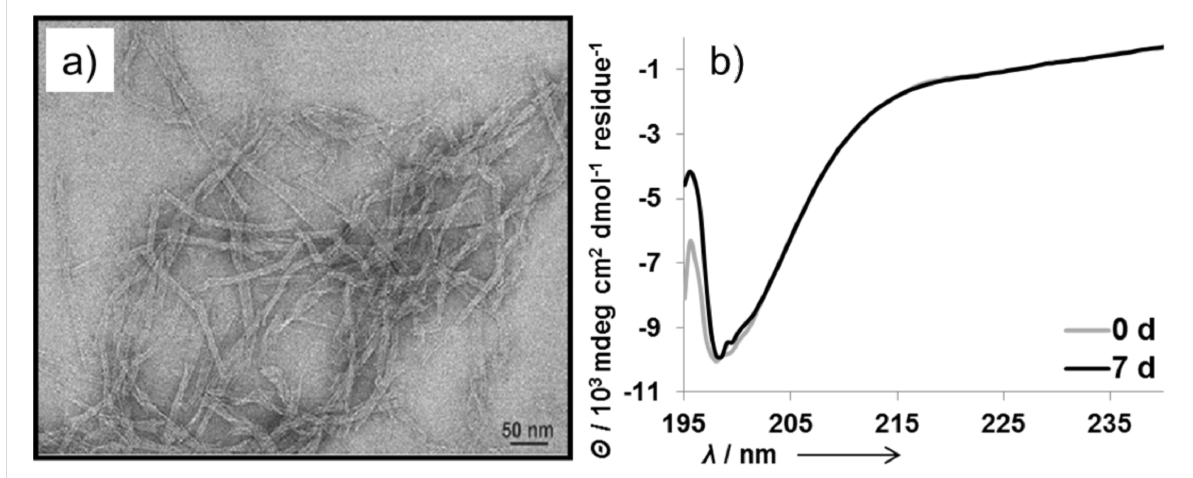
Figure 3: a) TEM micrograph of 15 µM KFM6 in 50 mM Tris/HCl buffer with 10 mM MgCl 2 at pH 7.5 and 24 °C. The peptide was incubated for 24 h in a closed cuvette in the presence of 5000 U PKA and 200 µM ATP and stained with 1% PTA (phosphortungstic acid). b) Time-dependent CD spectra of 30 µM P C KFM6 in 50 mM Tris/HCl buffer with 10 mM MgCl 2 pH 7.5 and 24